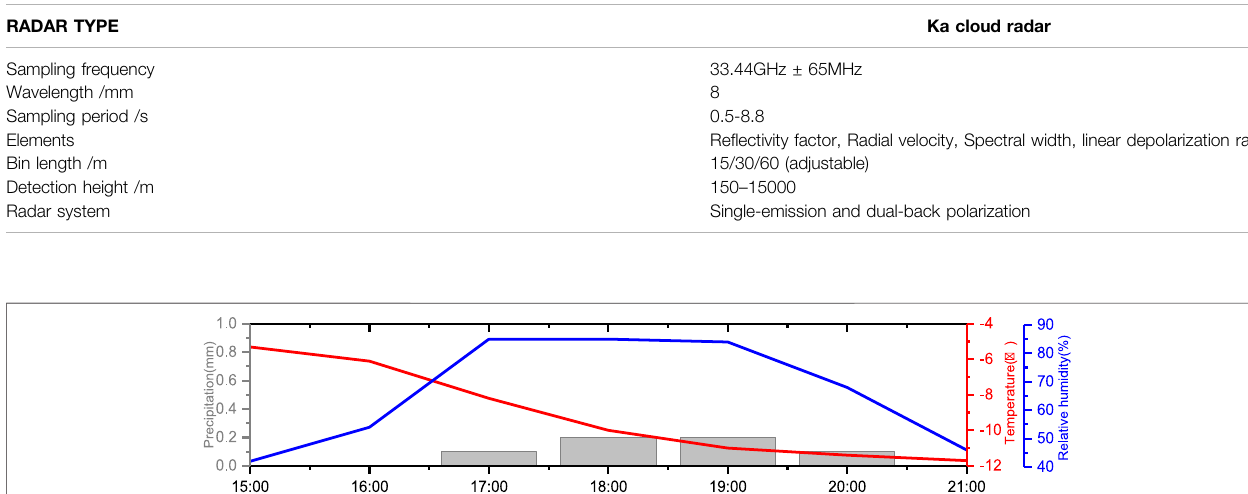
TABLE 2 | Cloud radar performances